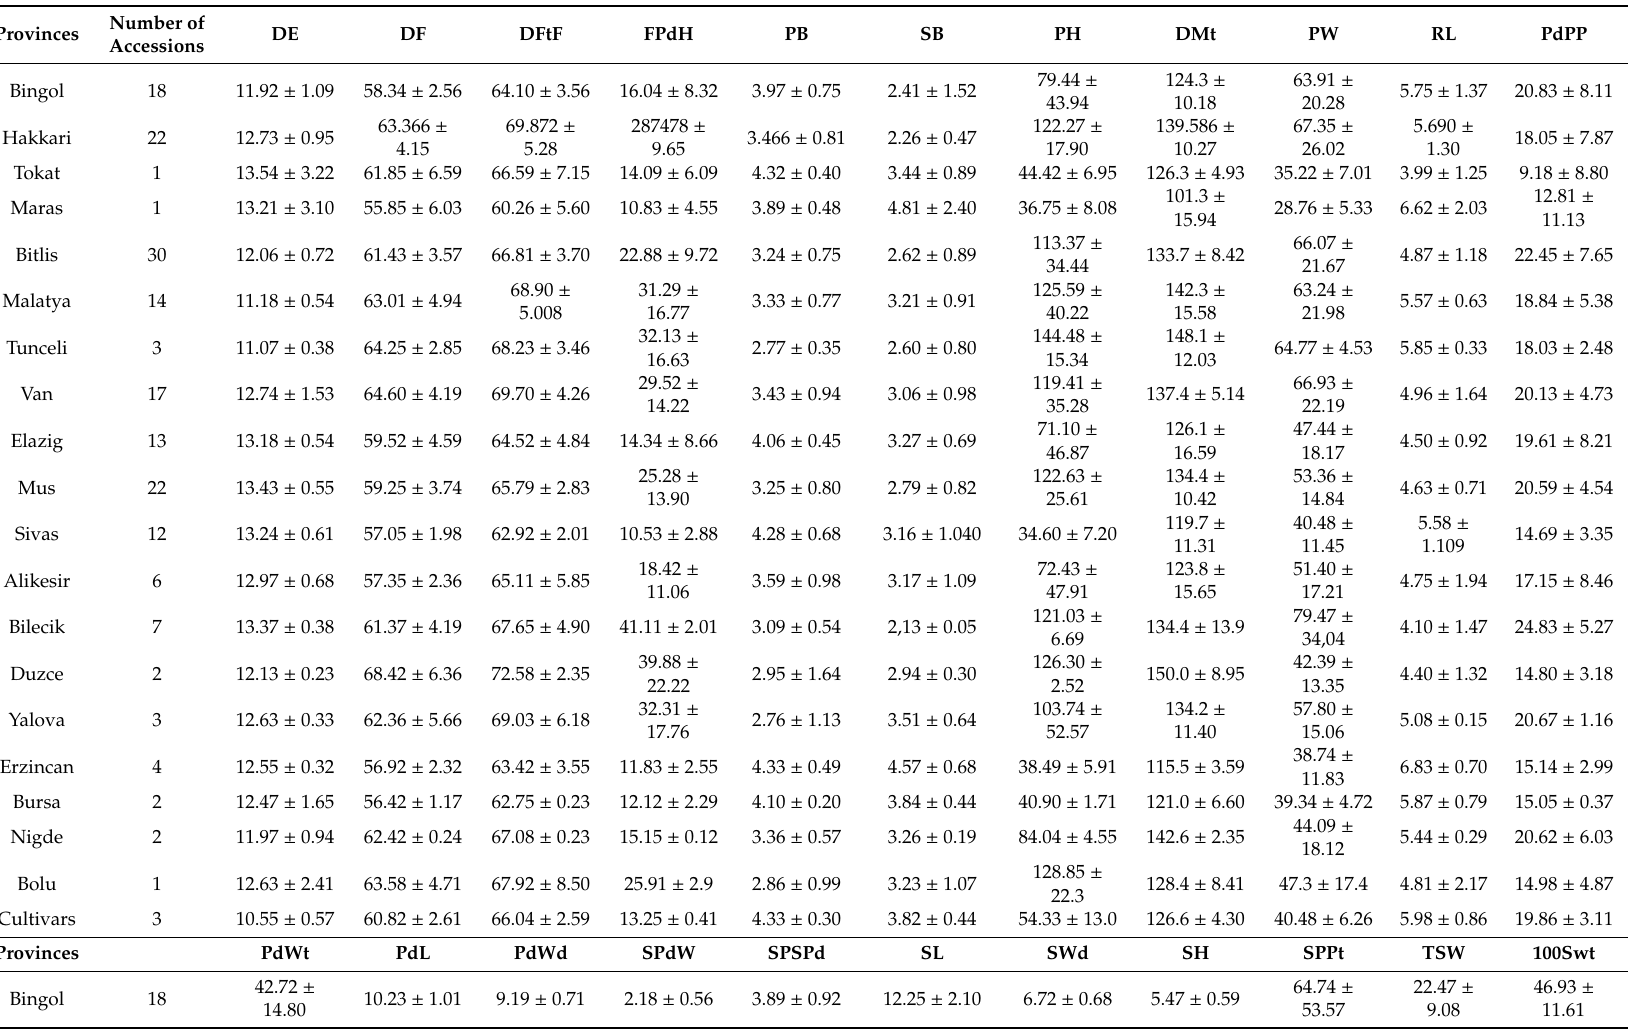
Table 4. Averaged values of the 22 traits for 180 accessions and three commercial cultivars of common bean based on the collection provinces in Turkey.